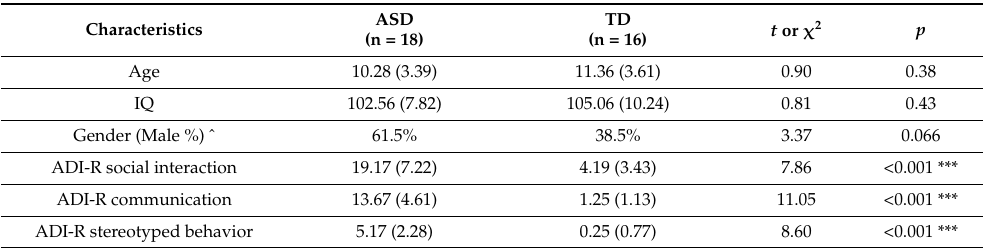
Table 1. Demographic and clinical characteristics of children with autism (ASD) and the typically developing (TD)